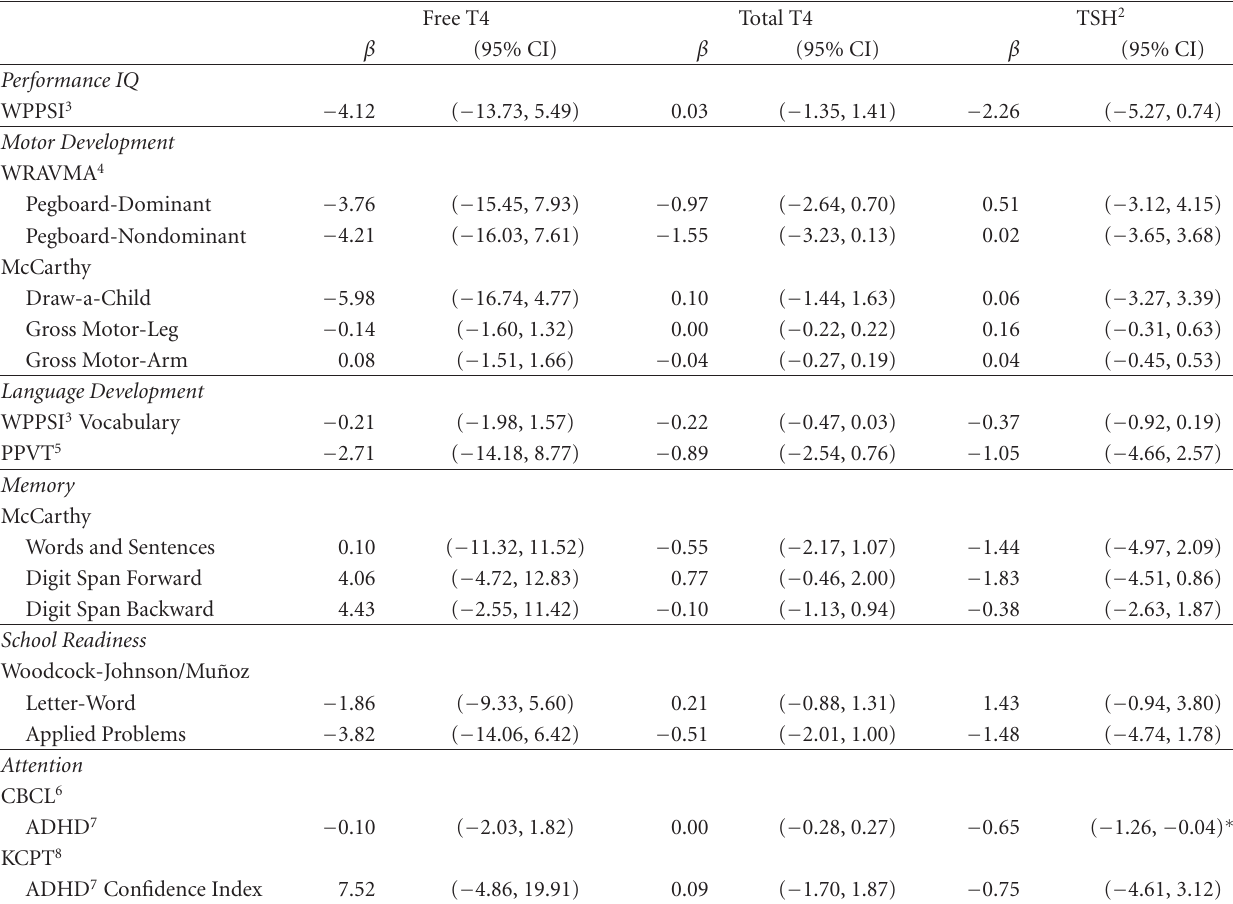
Table 5: Associations between maternal thyroid hormone levels during pregnancy (27 weeks’ gestation) and child neurodevelopment at 5 years of age.